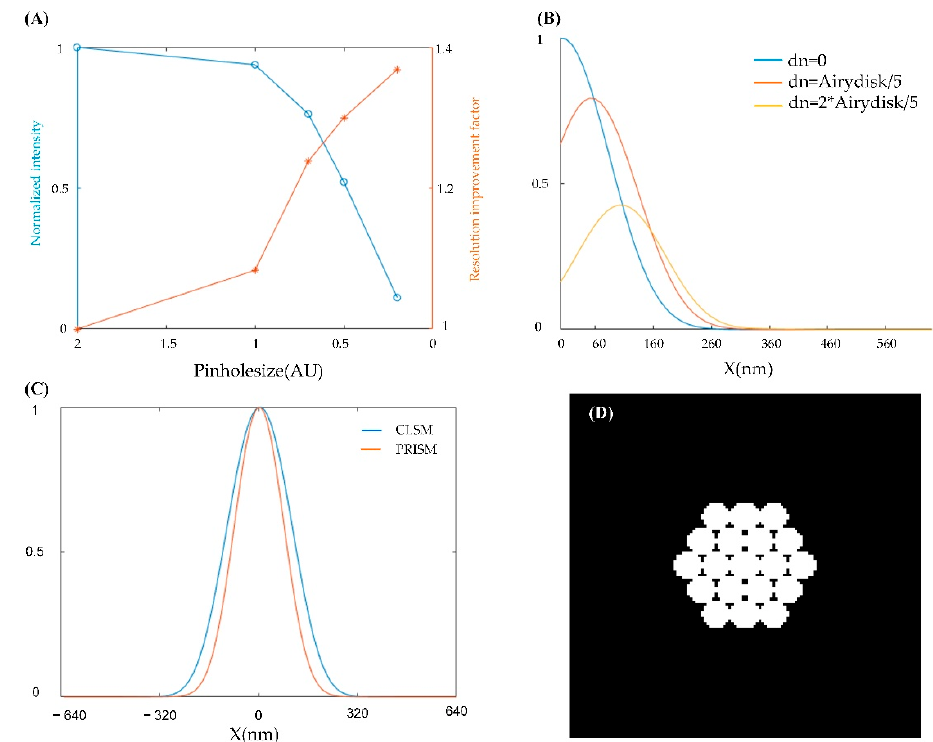
Figure 1. ( A ) The relative intensity and resolution change for different pinhole size in CLSM (confocal laser scanning microscopy); ( B ) Cross-section through the images of a point object detected by the pinholes with different offset distance dn; ( C ) The normalization cross-section profile comparison between the CLSM image detected by a pinhole with one AU and the PRISM (Pixel reassignment image scanning microscopy) image detected by a detector array which is shown in ( D ); ( D ) The detector array pattern with 19 pinholes used in this simulation and the diameter of the array is one AU. The wavelength of excitation light and emission light: 640 nm. AU: Airy Unit.